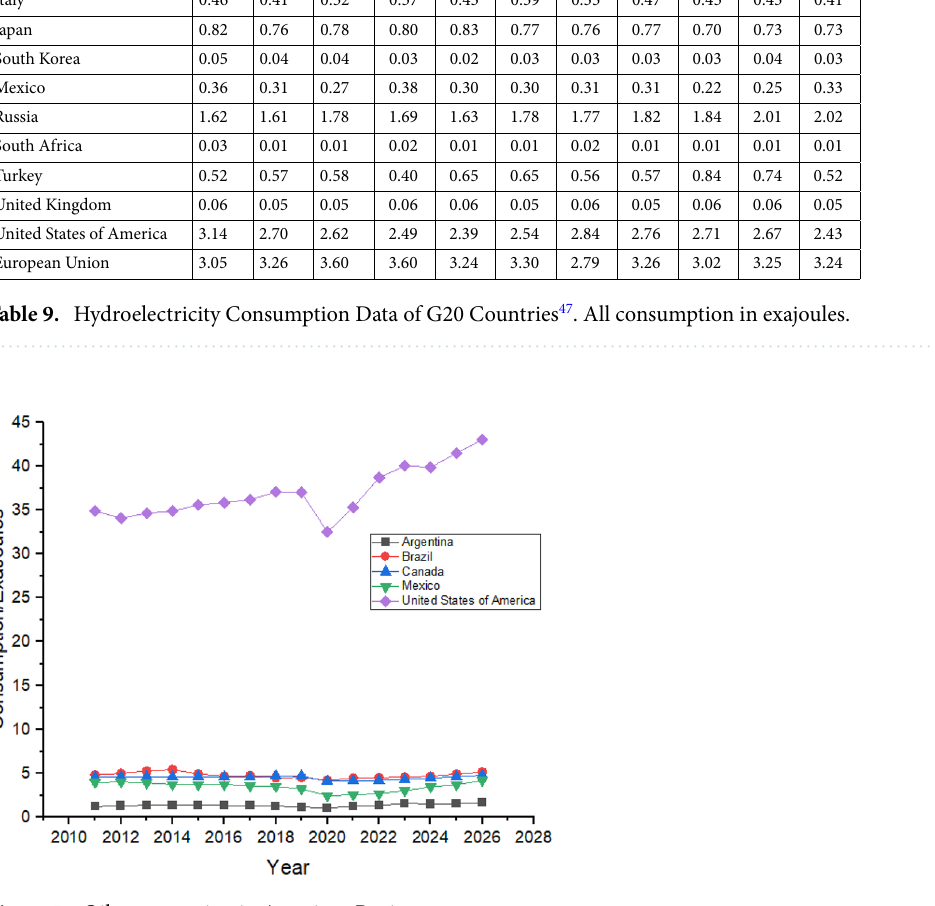
Figure 5. Oil consumption in American